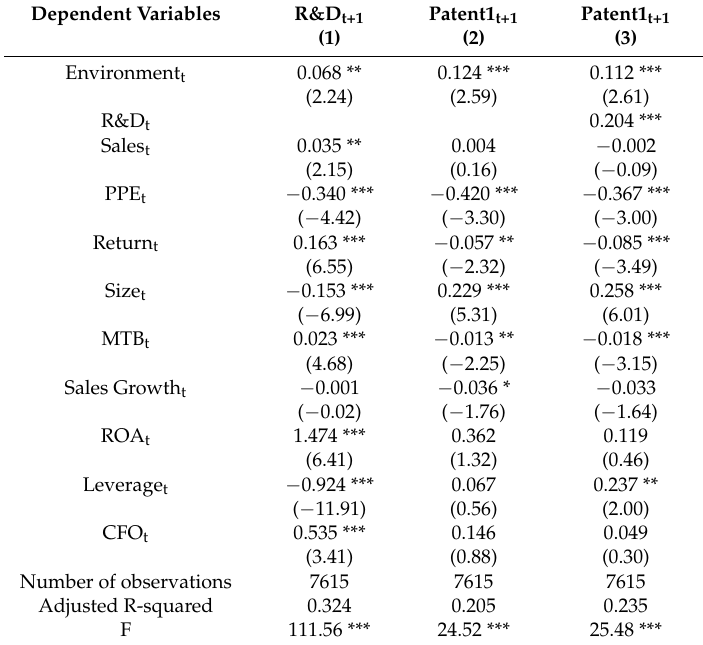
Table 4. CEOs’ environmental awareness and firms’